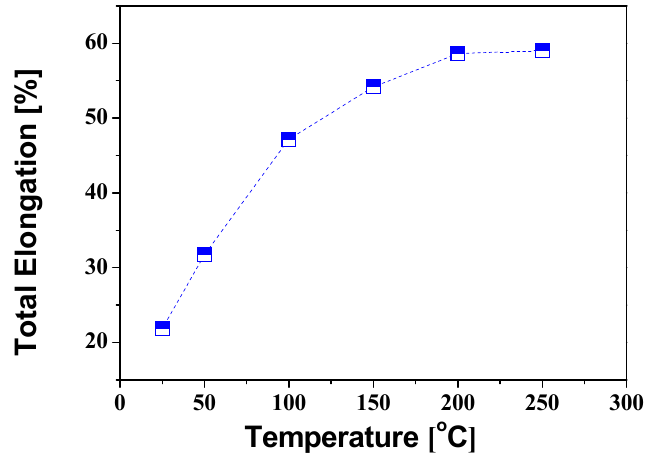
Figure 7. Relationship between the total elongation and the temperature of AZ31B. The microstructure was analyzed to study the behavior characteristics according to temperatures. The microstructures of the initial AZ31B at 20 °C and 250 °C are shown in Figure 8. At 20 °C, twinning, which results from the rolling process, is observed in the initial microstructure of AZ31B, as shown in Figure 8a. The deformation is limited due to twinning and less slip planes.